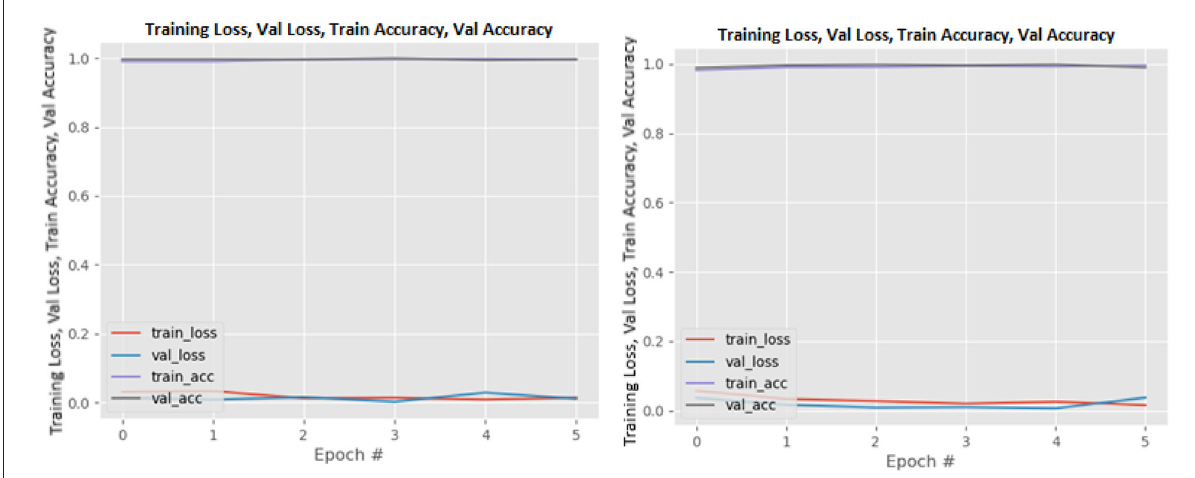
FIGURE17 VGG16 without data augmentation (left image) and with data augmentation (right image).